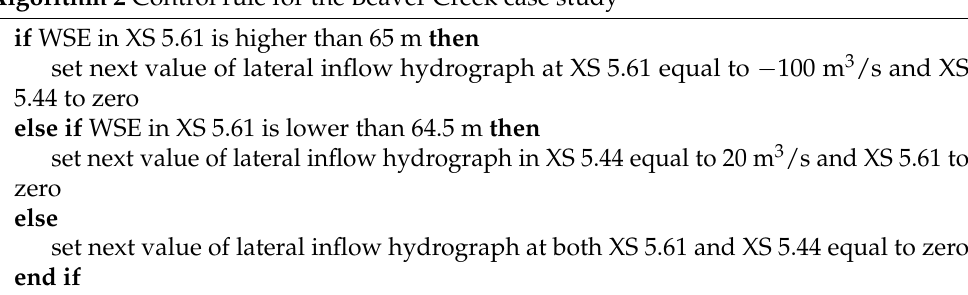
Algorithm 2 Control rule for the Beaver Creek case study